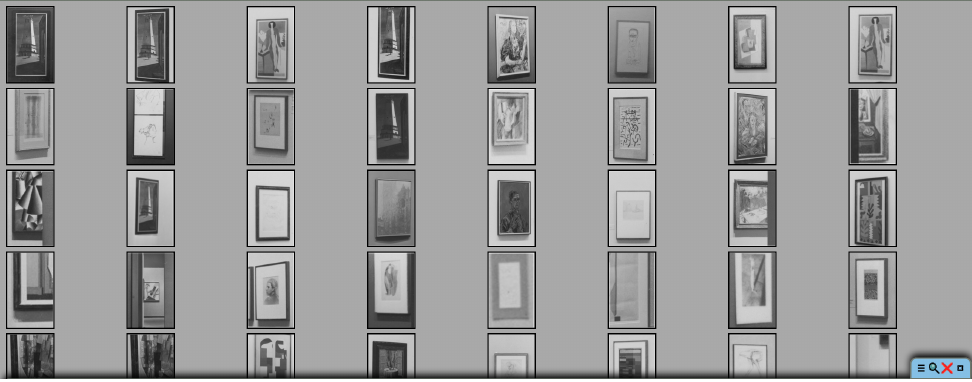
Figure 7. Search results using the interface for Giorgio de Chirico’s The Nostalgia of the Infinite. Image rights: Computer Vision Group, Heidelberg University. Displayed photographs/details belong to the Museum of Modern Art, New